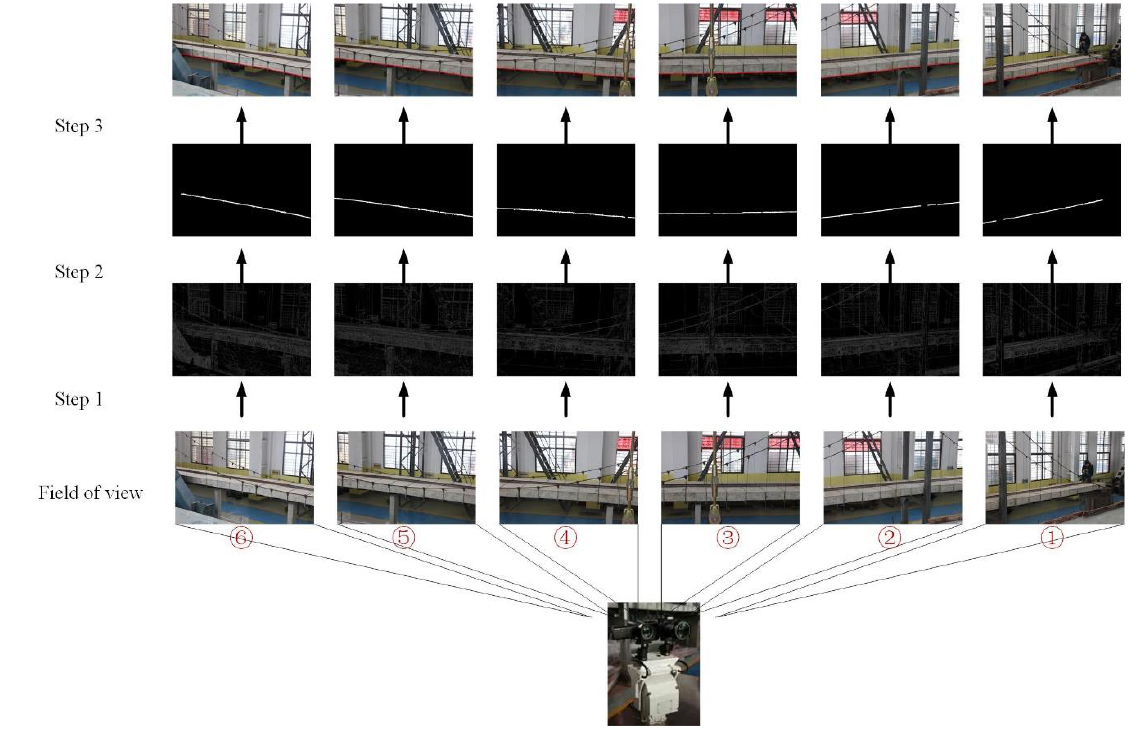
Figure 14. The workflow of denoising and marking of bridge contours. Step 1: Edge detection of static images; step 2: Acquisition of bridge contours through decontextualization of useless contours; step 3: Marking the original images based on the coordinates of boundary pixels .